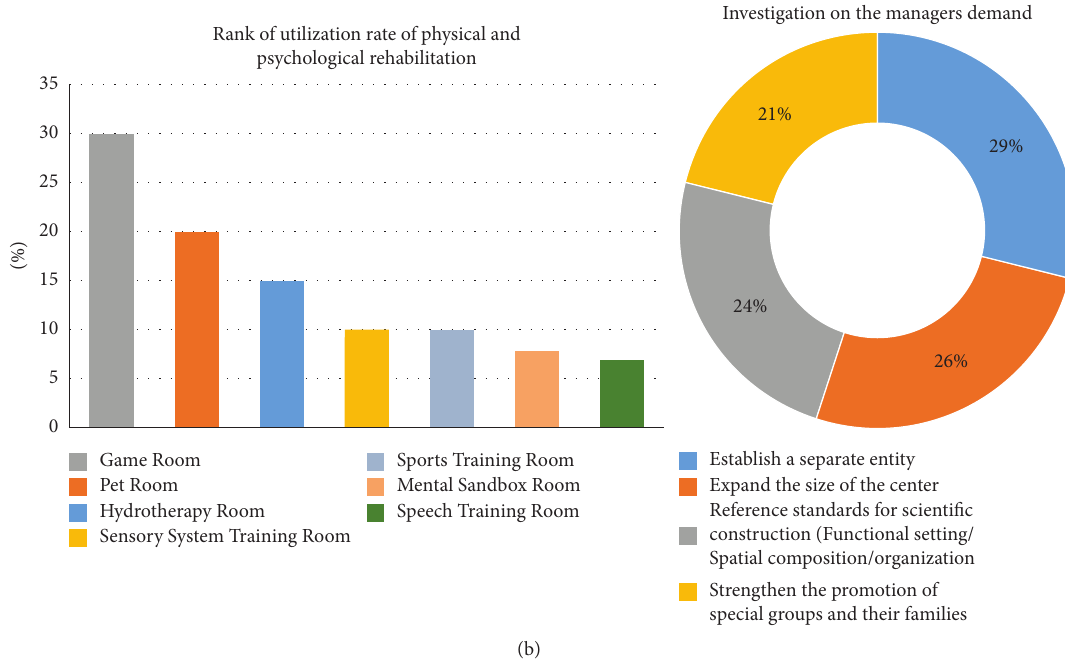
Figure 4: Survey chart of user satisfaction and